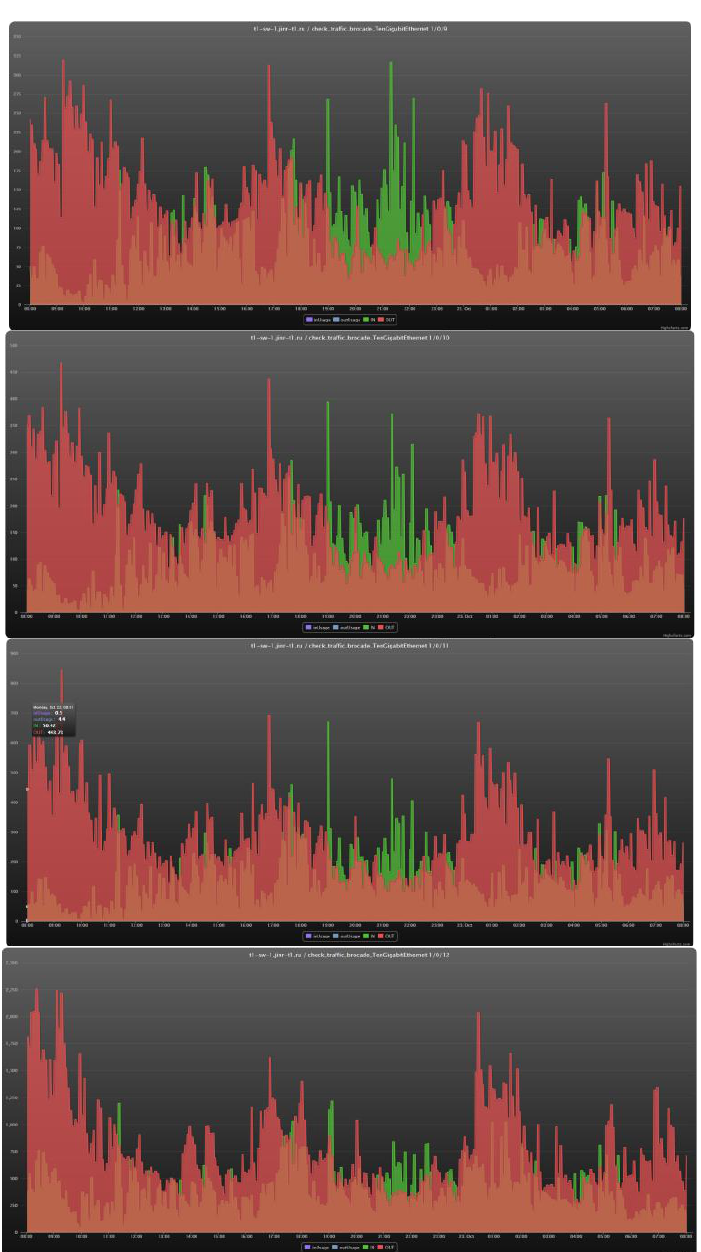
Fig. 6. Incoming/outgoing traffic of TenGigabit 09-012 network